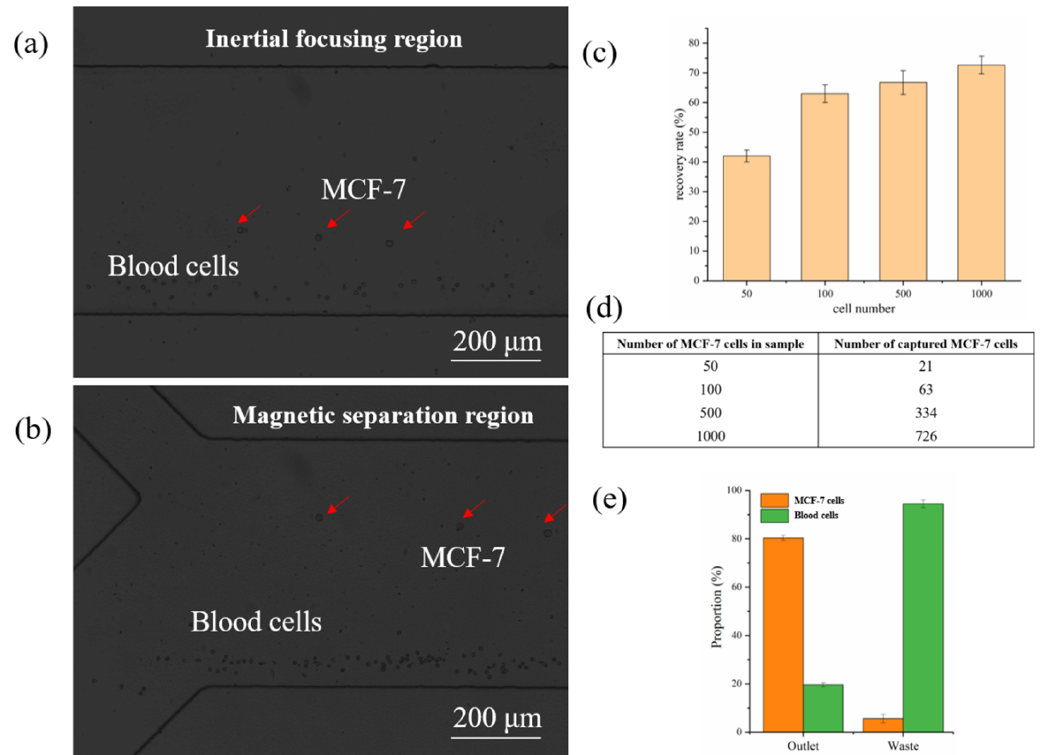
Figure 6. ( a ) The migration performance of the blood cells and MCF-7 cells in the inertial focusing region, where the migrating trajectories of blood cells were located near the inner wall and the MCF-7 cells began to migrate towards the outer wall; ( b ) the migration performance of the blood cells and MCF-7 cells in the magnetic separation region, where MCF-7 cells were dragged by the immunomagnetic beads and flowed out from the separation outlet while the blood cells flowed out from the waste outlet; ( c ) the recovery rate of different numbers of spiked MCF-7 cells; ( d ) the spiked number and captured number of MCF-7 cells, and ( e ) proportion of MCF-7 cells and blood cells in outlet and waste.